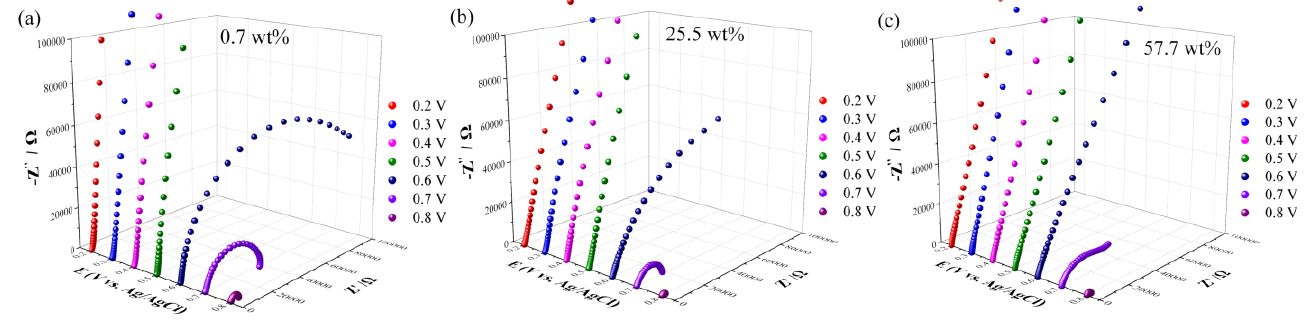
Figure 3. ( a – c ) Electrochemical impedance spectra of Au electrode in ethaline with different water contents at various potentials: ( a ) 0.7 wt%, ( b ) 25.5 wt%, ( c ) 57.7 wt%.AC amplitude: 10 mV; frequency range: 10 5 – 1 Hz.